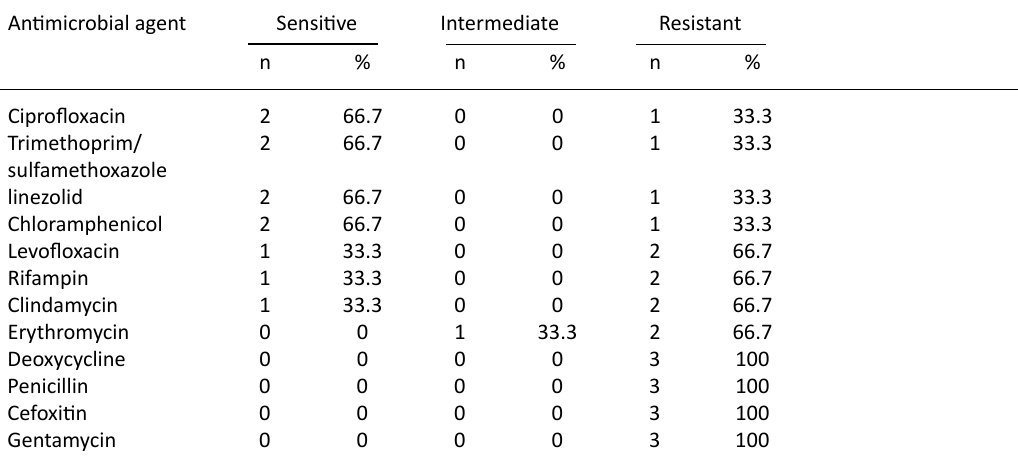
Table 2. Frequencies (n) and percentages (%) for antimicrobial susceptibility of MRSA in mecC positive cases (n = 3) arranged from highest to lowest sensitivity Antimicrobial agent Sensitive